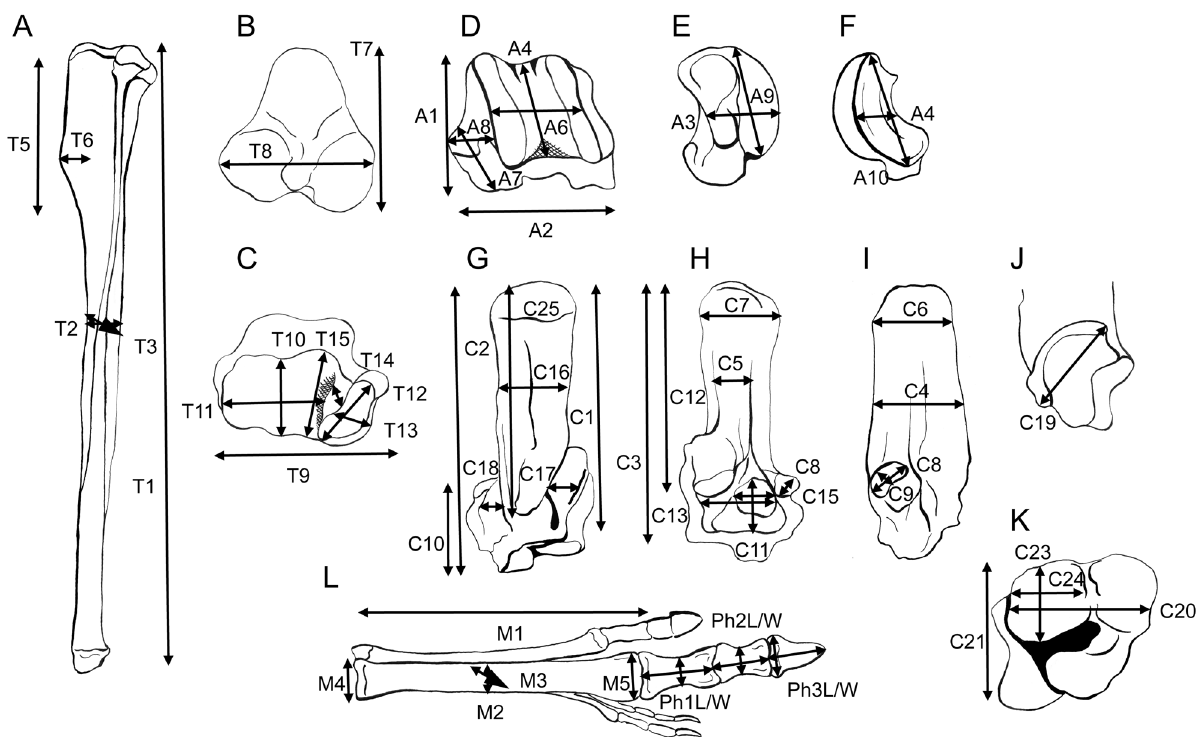
Figure 9. Measurements used in analyses-2. Drawings, all of left side elements, primarily from photographs of Macropus fuliginosus , AMNH 2390, Calcaneum from Macropus giganteus , AMNH 74753). (A) Tibia, lateral view (fibula removed). (B) Tibia, proximal articular view (plantar side downwards). (C) Tibia, distal articular view (plantar side upwards). (D) Astragalus, anterior (dorsal) view. (E) Astragalus, medial view. (F) Astragalus, lateral view. (G) Calcaneum, anterior (dorsal) view. (H) Calcaneum, posterior (plantar) view. (I) Calcaneum, lateral view. (J) Calcaneum (head only) medial view. (K) Calcaneum, distal articular view (plantar side upwards). (L) Pes, anterior (dorsal) view. A detailed description of the measurements is provided in Table